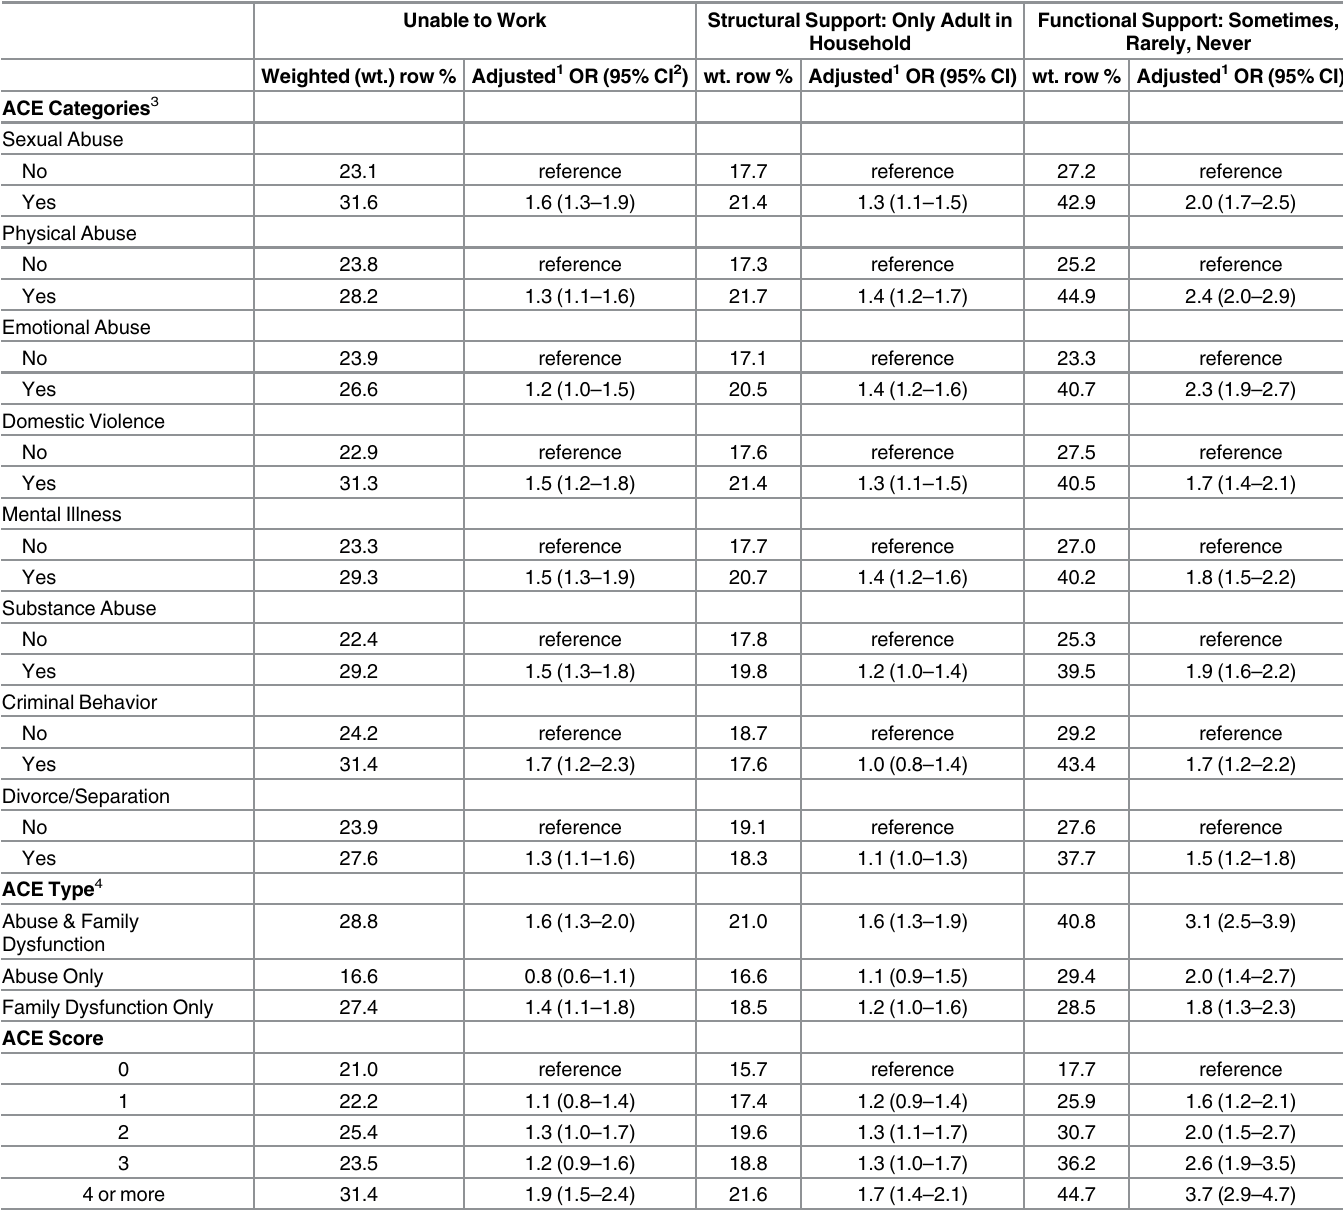
Table 3. Relationship between Adverse Childhood Experience (ACE) Categories, Type and Score with Perceived Inability to Work and Support. Unable to